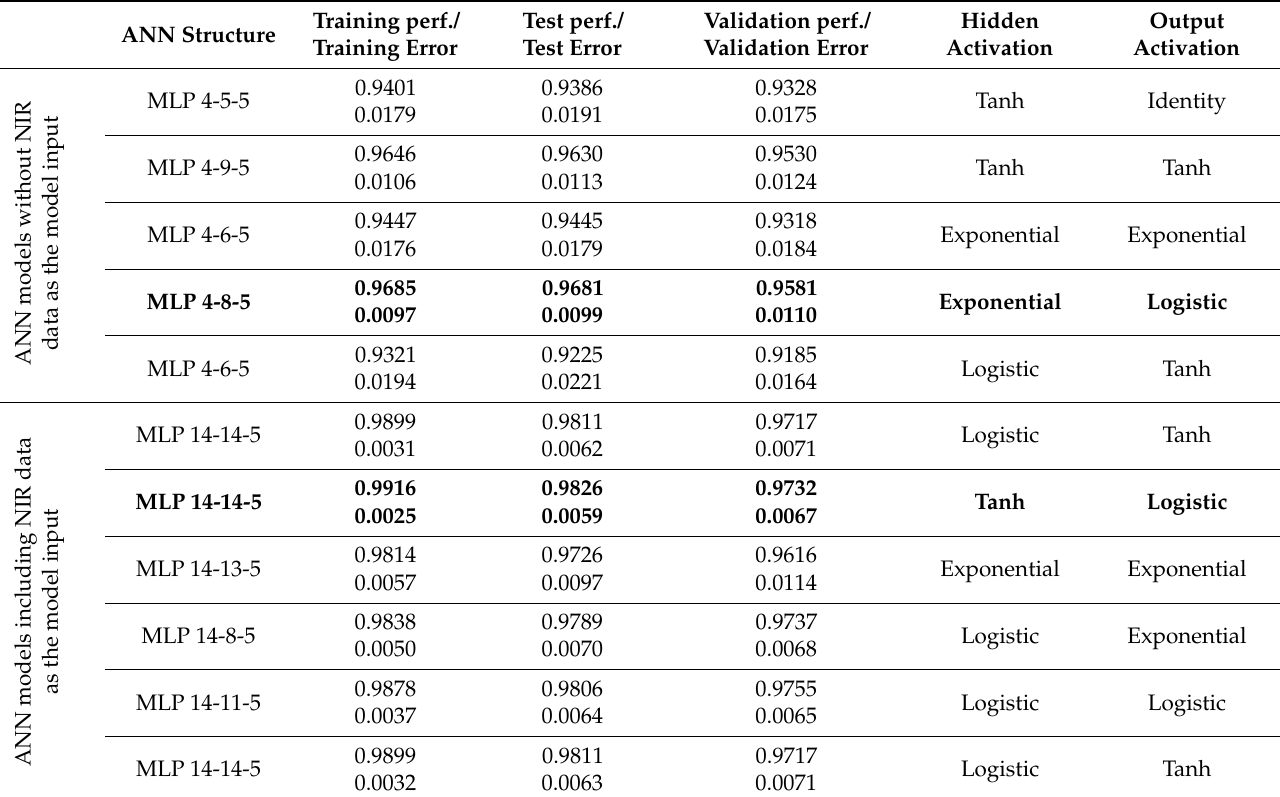
Figure 3. Raw NIR spectra of all water samples collected in July. Table 4. Characteristics of the generated artificial neural